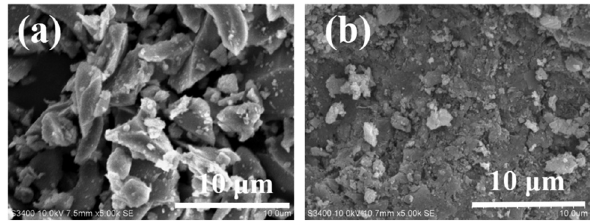
Figure 7: The SEM images of ( a ) cement and ( b ) cement binder.